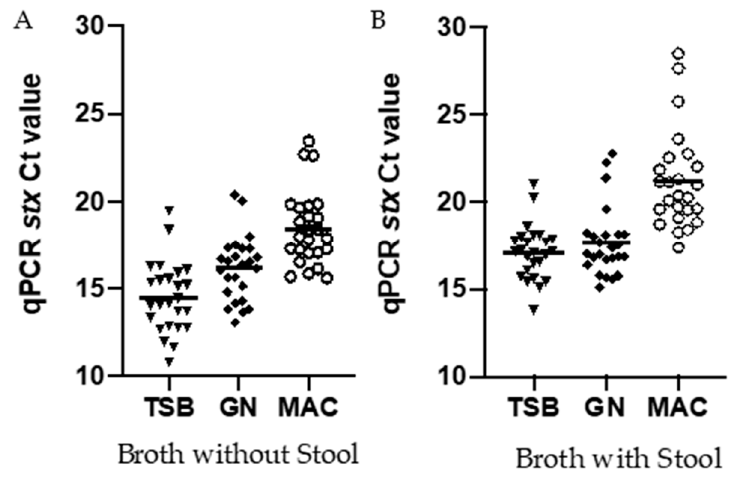
Figure 4. qPCR Ct values of stx from STEC isolates enriched in tryptic soy broth (TSB), GN, and Figure 4. ( A ) represent broth without Stool, ( B ) represent broth with Stool. qPCR Ct values of MacConkey (MAC) with and without stool. DNA was extracted from the STEC enriched broth stx from STEC isolates enriched in tryptic soy broth (TSB), GN, and MacConkey (MAC) with and and qPCR was done. Each symbol represents a single isolate. n = 25 isolates. without stool. DNA was extracted from the STEC enriched broth and qPCR was done. Each symbol represents a single isolate. n = 25